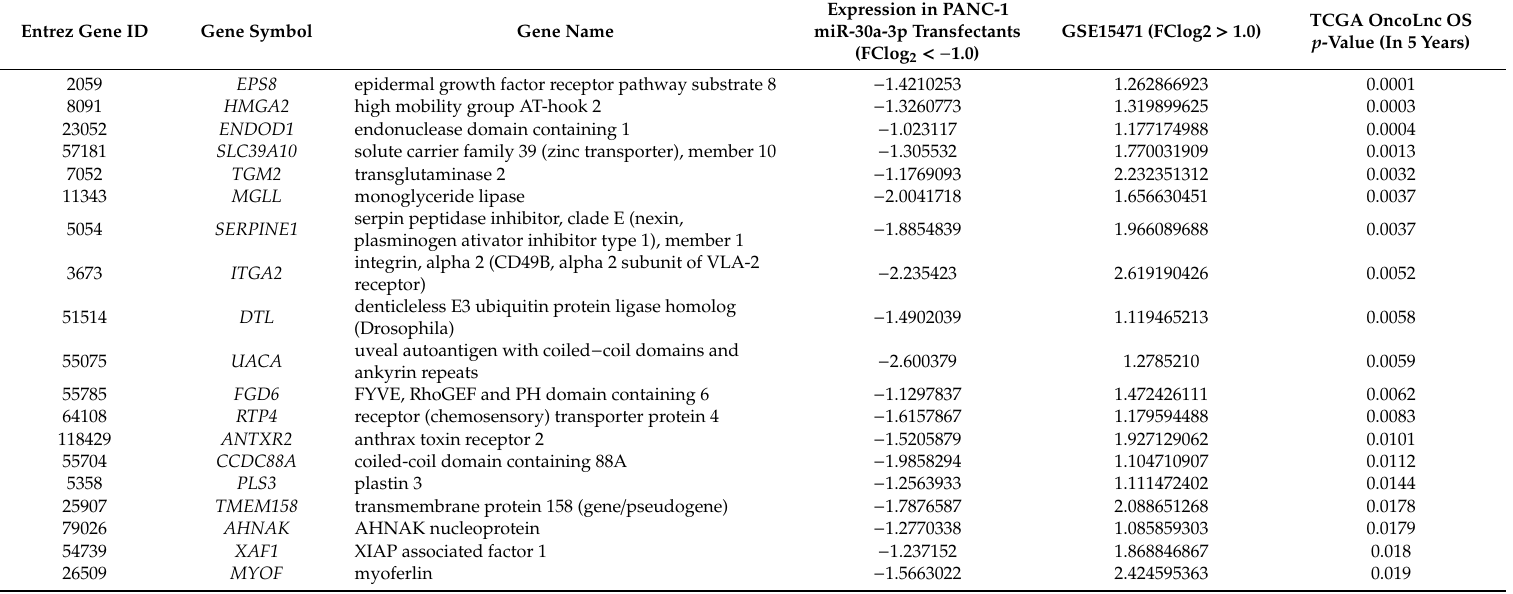
Table 1. Identification of putative targets regulated by miR-30a-3p in PDAC